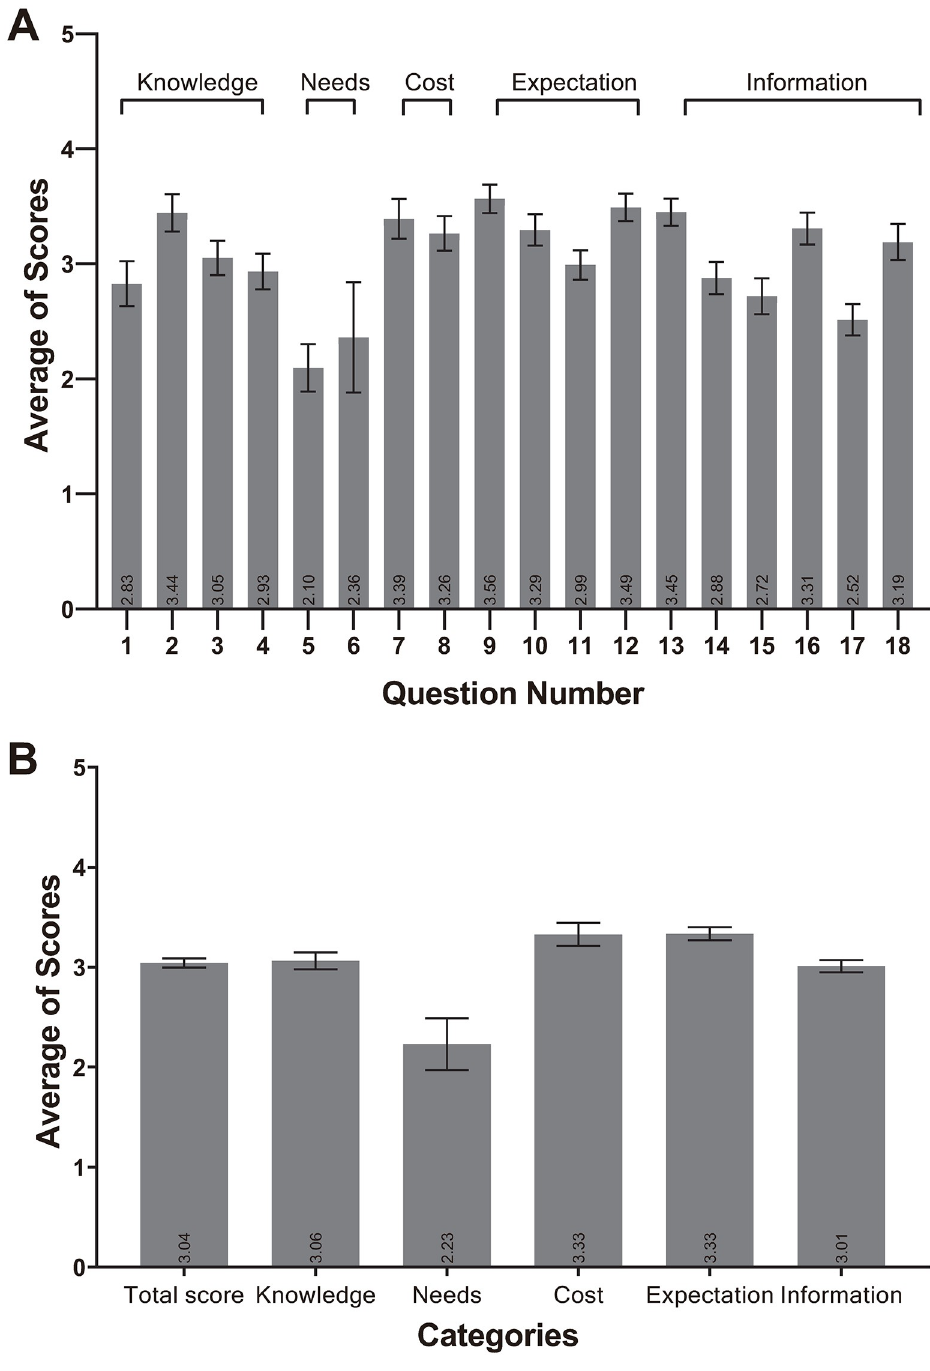
Fig 2. Average scores of the perception survey. (A) Average scores of 18 questions (rated by question). (B) Average scores of five categories (rated by category). Error bars indicate confidence interval (CI).